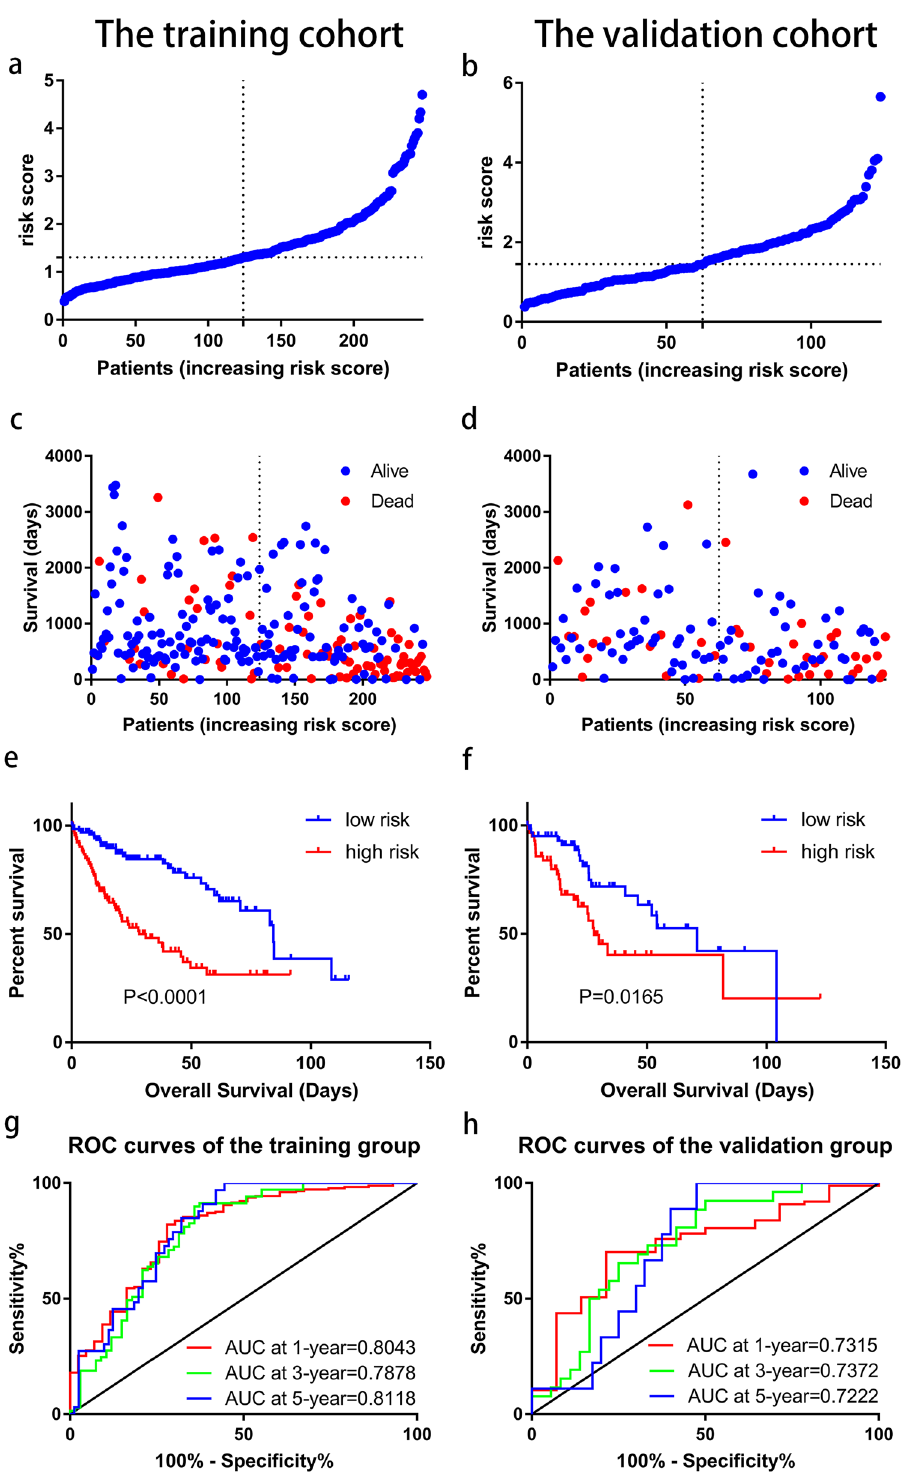
Figure 4. Prognostic analysis of pyroptosis-related lncRNA signature in the training cohort and validation cohort. ( a ) The distribution of the risk scores in the training cohort. ( b ) The distribution of the risk scores in the validation cohort. ( c ) The distributions of overall survival status, overall survival, and risk score in the training cohort. ( d ) The distributions of overall survival status, overall survival, and risk score in the validation cohort. ( e ) Kaplan–Meier curves for the overall survival of patients in the high- and low-risk groups in the training cohort. ( f ) Kaplan–Meier curves for the overall survival of patients in the high- and low-risk groups in the validation cohort. ( g ) AUC of time-dependent ROC curves verified the prognostic accuracy of the risk score in the training cohort. ( h ) AUC of time-dependent ROC curves verified the prognostic accuracy of the risk score in the validation